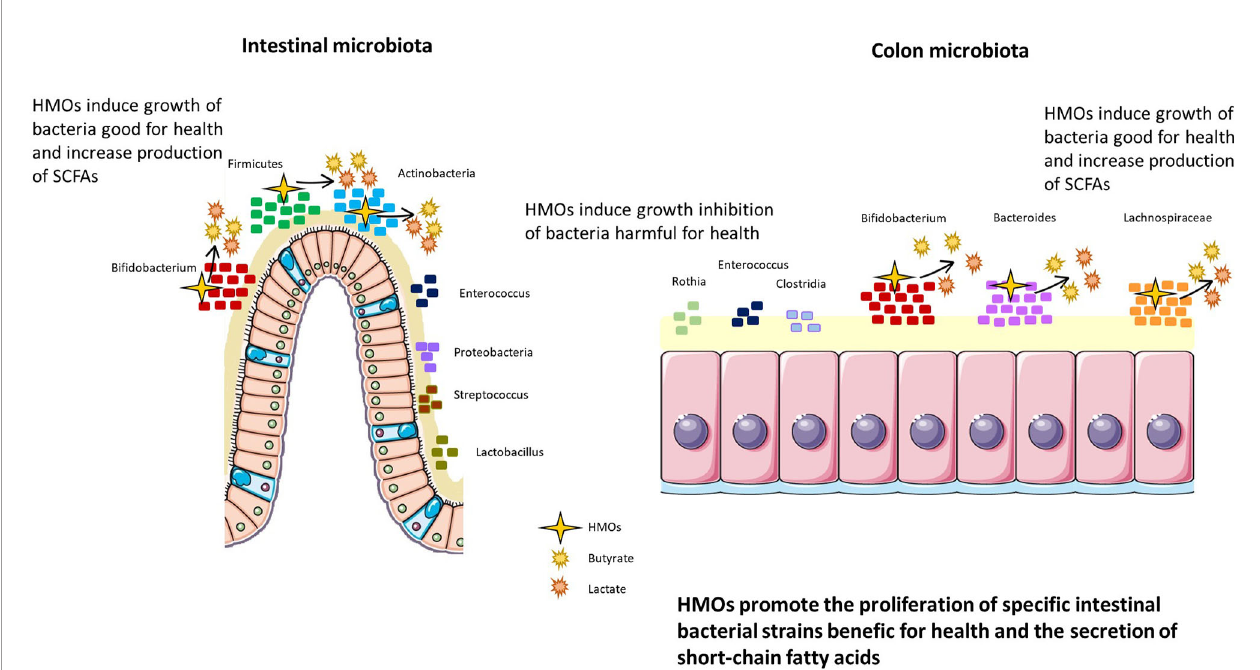
FIGURE 4 | HMOs promote the proliferation of speci fi c intestinal bacterial strains bene fi cial for health and promote the secretion of short-chain fatty acids. HMOs modulate the intestinal and colon microbiota, inducing the proliferation of Bi fi dobacterium, Firmicutes, and Actinobacteria in the intestine and Bi fi dobacterium, Bacteroides, and Lachnospiraceae in the colon. In parallel, HMOs decrease populations of bacteria harmful to health, such as Enterococcus, Proteobacteria, Streptococcus, and Lactobacillus in the intestine and Rothia, Enterococcus, and Clostridia in the